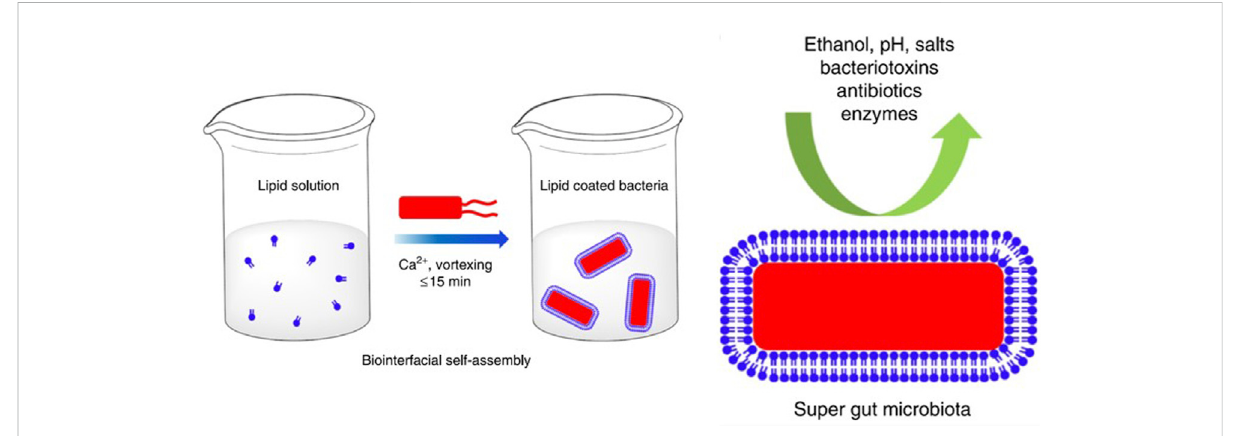
FIGURE 2 Schematic diagram of lipid membrane-coated bacteria via bio-interfacial